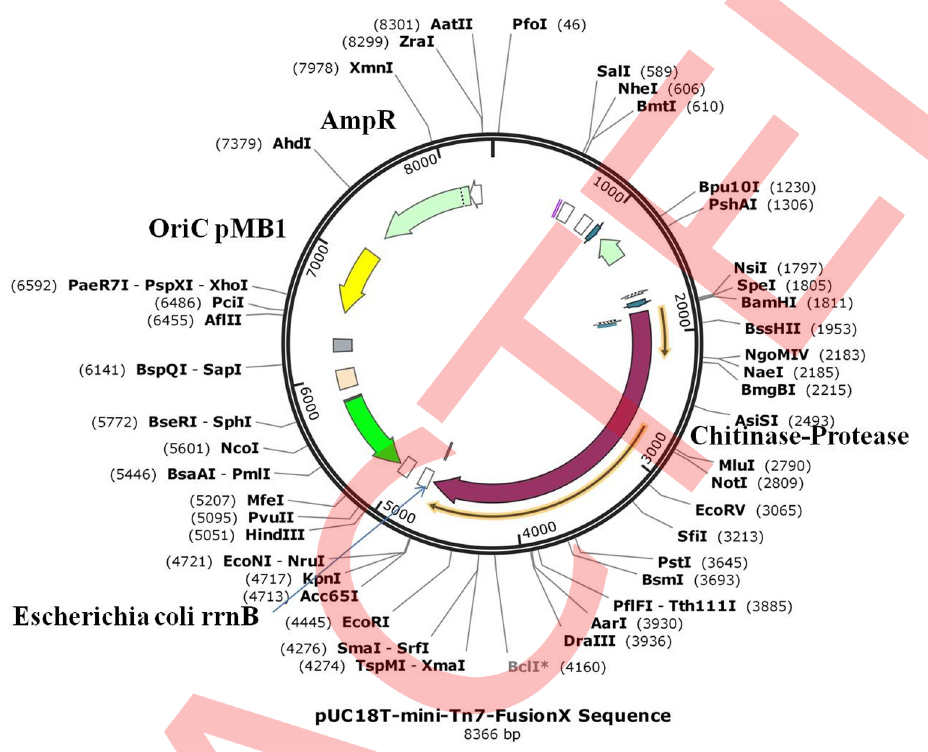
Fig 1. The map of pUC18-T7 mini vector with E . Coli rrnB transcription termination. Lac promoter (Blue color), Lac UV 5 Promoter (Blue color), Lac Operator (Blue color), Fusion Gene (purple color), rrnB T1 terminator